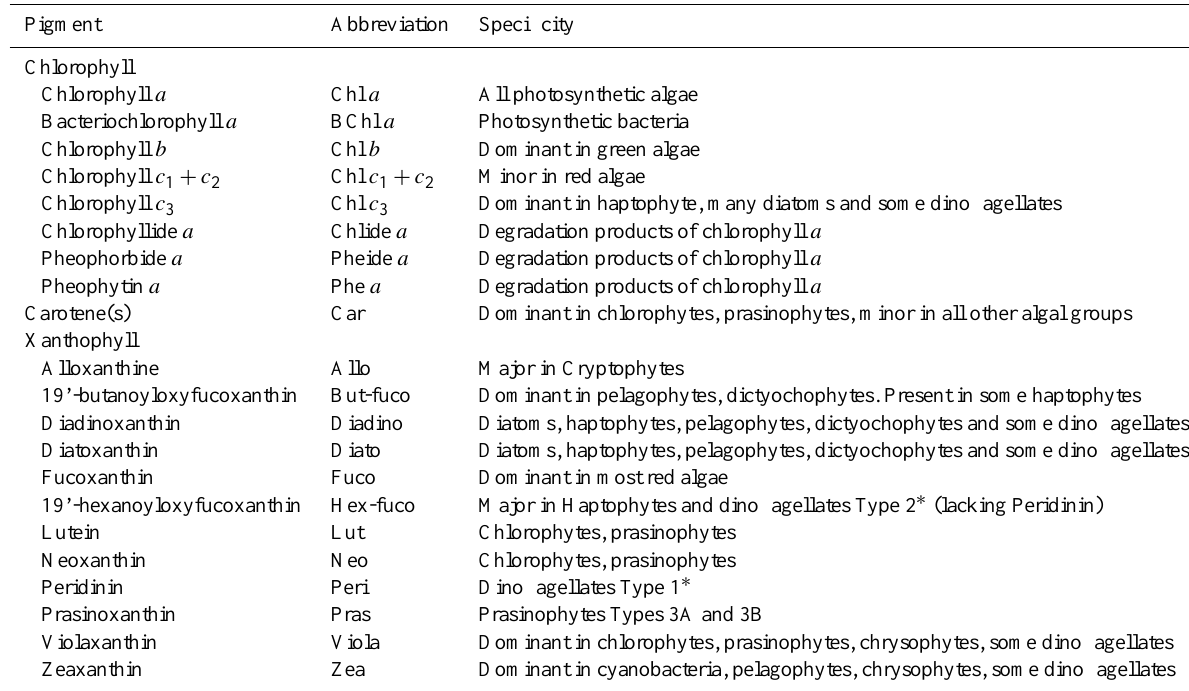
Table 1. Distribution of major taxonomically significant pigments in algal classes using SCOR (Scientific Council for Oceanic Research) abbreviations (Jeffrey et al.,